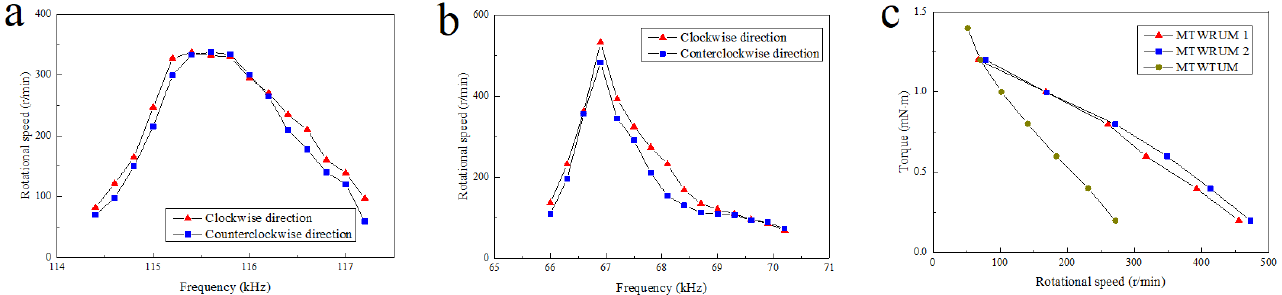
Figure 16. The output characteristics of the ultrasonic motors. ( a ) Rotational speed of the MTWRUM versus excitation voltage frequency; ( b ) rotational speed of the MTWTUM versus excitation voltage frequency; ( c ) output torques versus rotational speed of the ultrasonic